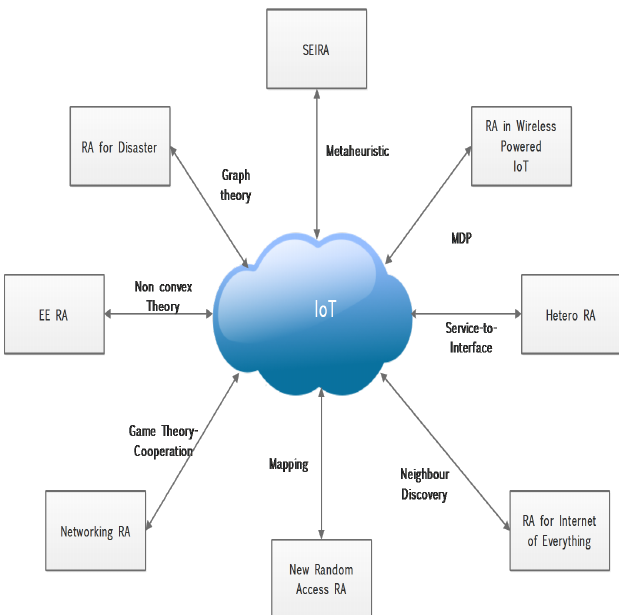
Figure 1. Popular recent resource allocation in